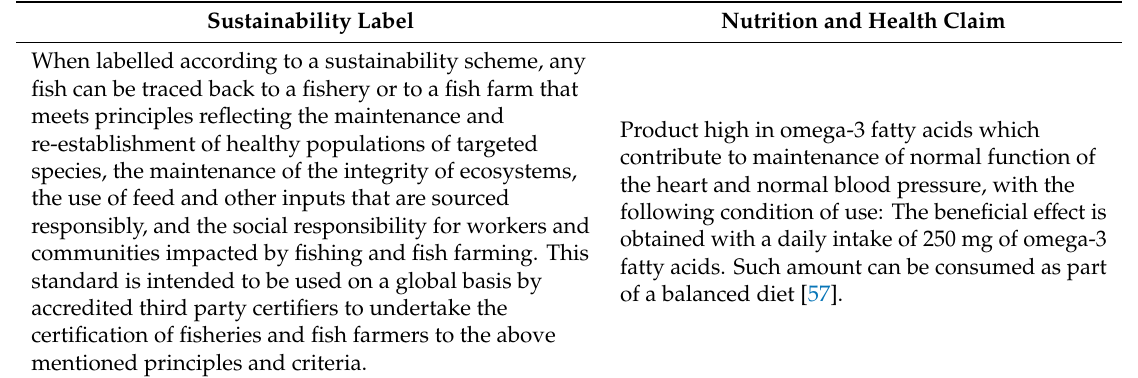
Table 2. Sustainability label and Nutrition and Health Claim used in the experiment. Sustainability Label